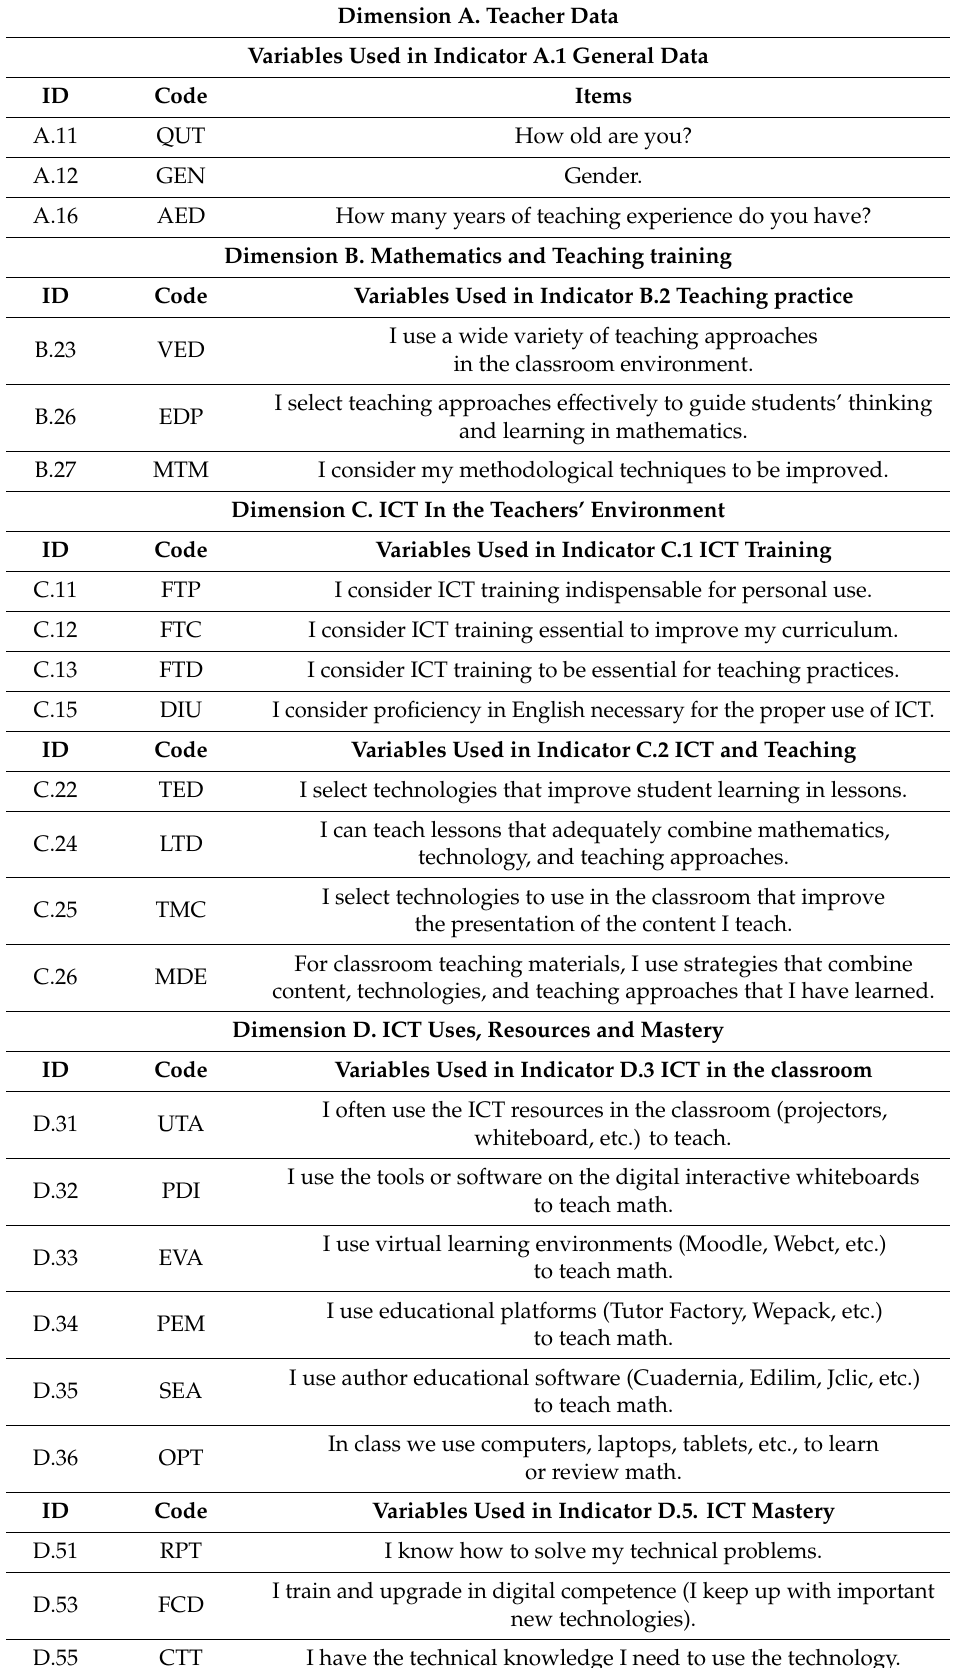
Table 1. Relationships among items, indicators, dimensions, and coding used in the questionnaire. Information and communication technology